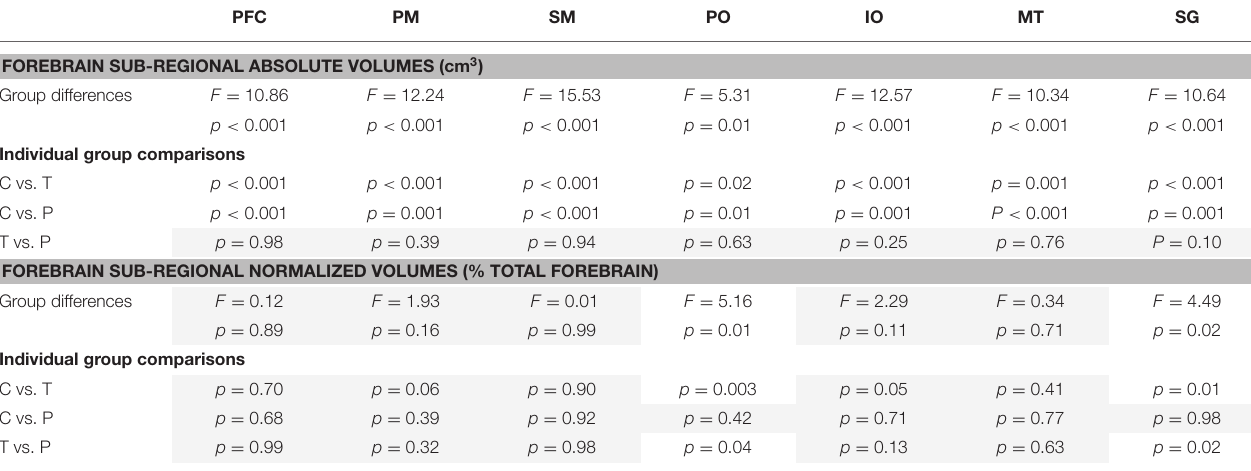
TABLE 3 | Analysis of sub-regional forebrain